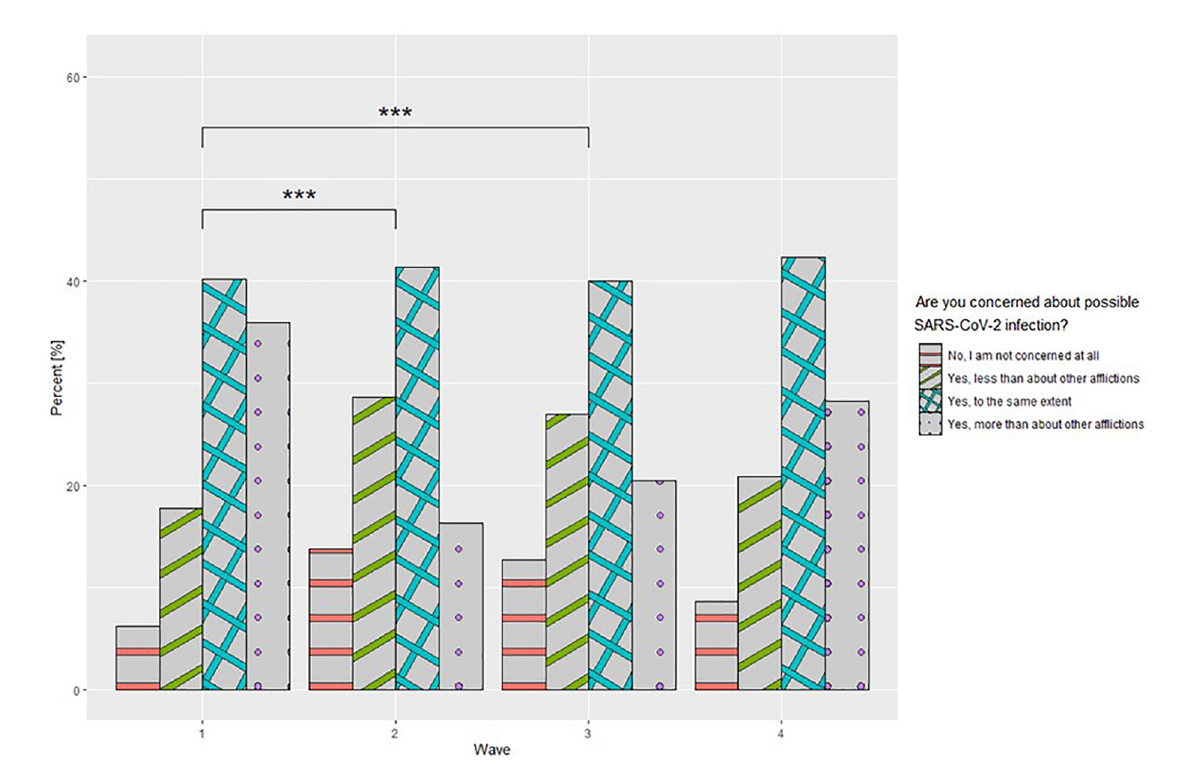
FIGURE3 Fear of COVID-19 infection concerning other conditions at different stages of the study. *** p < 0.001.